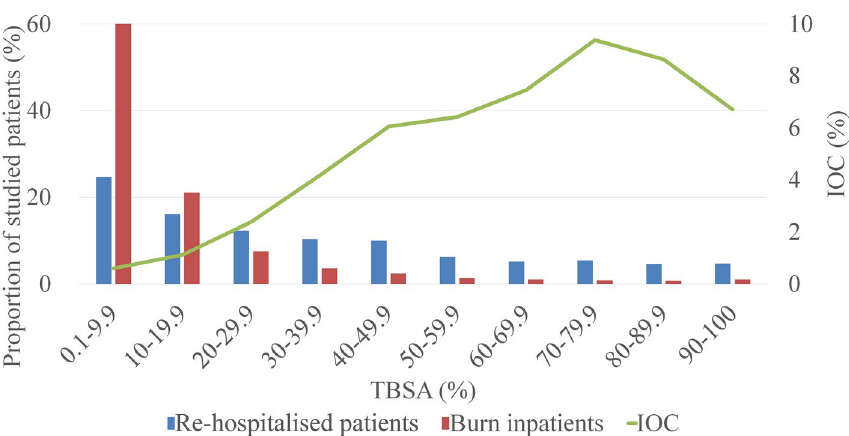
Figure 3. Proportions of burned inpatients and scar contracture-associated re-hospitalised inpatients along with IOC in different TBSA burned groups. The X-axis represents the percentage of TBSA burned groups. The left Y-axis corresponding to the bars represents the proportion of each group in the studied population. The right Y-axis corresponding to the line graph represents the IOC values. Abbreviations: IOC the incidence of scar contracture associated re-hospitalisation. TBSA total body superficial